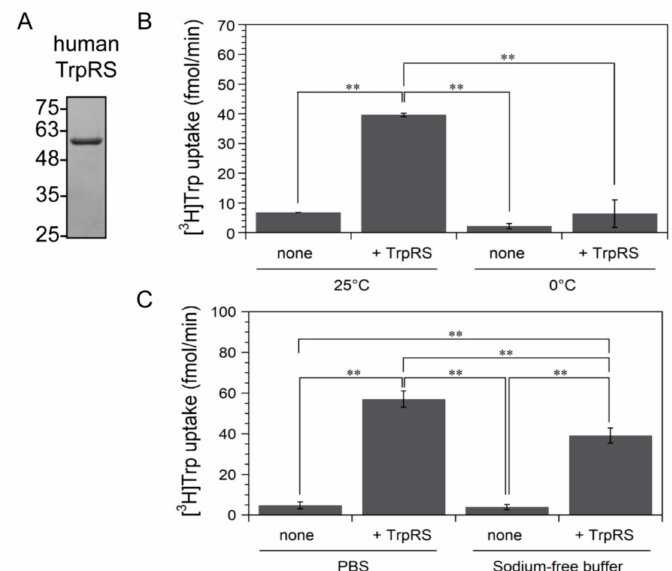
Figure 1. The e ff ect of adding purified human tryptophanyl-tRNA synthetase (TrpRS) protein to the assay bu ff er on [ 3 H]Trp uptake by HeLa cells. ( A ) SDS-PAGE analysis of purified human TrpRS protein. The gel was stained with Coomassie Brilliant Blue. Molecular size markers (kDa) are shown on the left. ( B ) [ 3 H]Trp uptake at 25 or 0 ◦ C. All data are given as mean ± standard deviation (SD) of three independent experiments. ** p < 0.01. ( C ) [ 3 H]Trp uptake into cells in phosphate-bu ff ered saline (PBS) or sodium-free Tris-choline bu ff er at 25 ◦ C. All data are given as mean ± SD of three independent experiments. ** p <